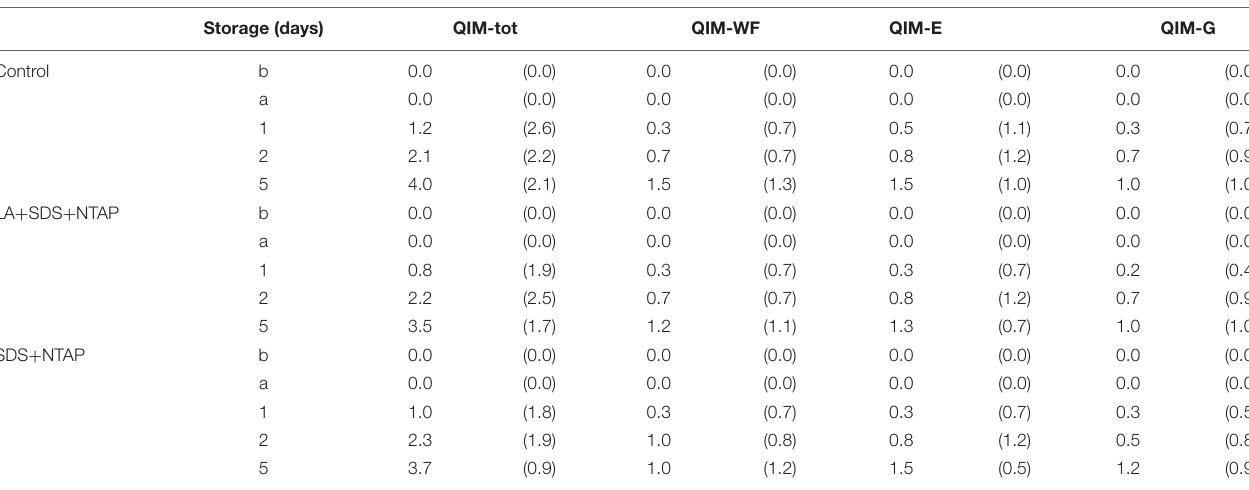
FIGURE 4 | Histamine concentration ( µ g/g) in fish meat inoculated with M. psychrotolerans (A) and P. phosphoreum (B) after 10 days at 5 ◦ C. TABLE 3 | Quality index results (mean and standard deviation) over the storage